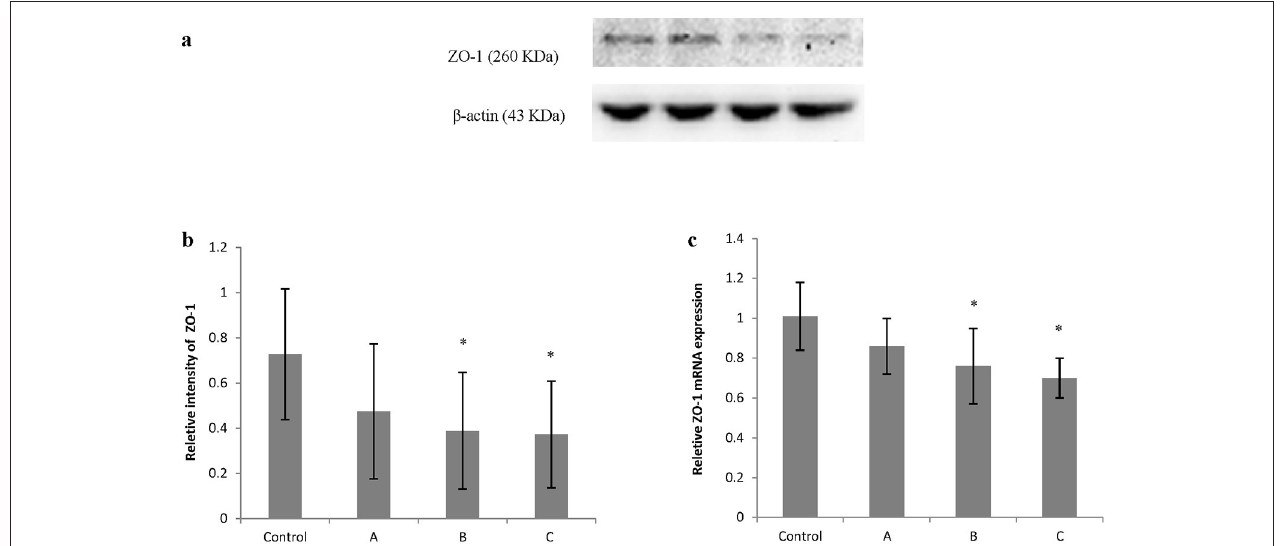
FIGURE 5 | Comparison of ZO-1 protein and mRNA levels in mouse brain among groups. The number of mice used for Western blots and real-time RT-PCR were 10 in control, 9 in group A, 8 in group B, and 8 in group C. Data were given as mean ± SD , and analyzed by one-way ANOVA. Significant difference was defined as P < 0.05, * vs. control group. (a) Western blot analysis; (b) Densitometric analysis of Western blots; (c) Quantitation of mRNA by real-time RT-PCR. The mRNA levels were normalized to GAPDH and presented as fold change vs. control group.